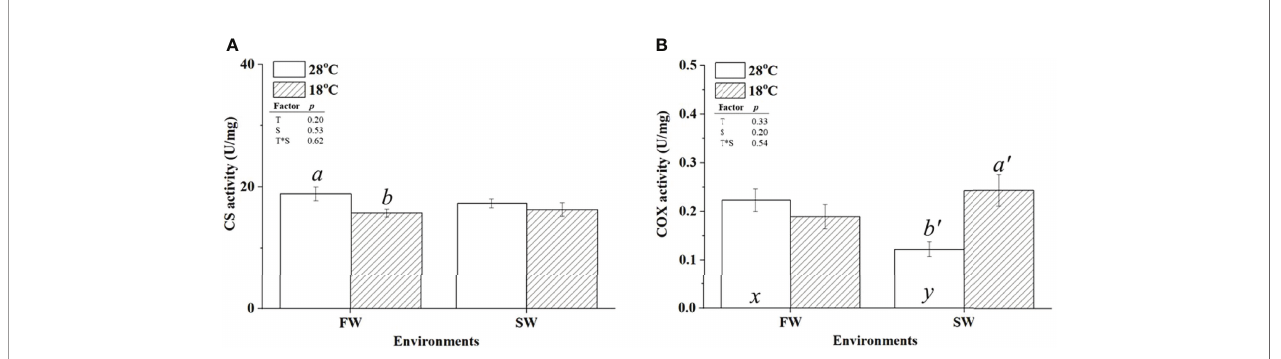
FIGURE 5 | Activity levels of citrate synthase (CS) (A) and cytochrome c oxidase IV (COX IV) (B) in the gills of milk fi sh acclimated to 28°C (white bar) and 18°C (striped bar). Different letters in the FW milk fi sh (a, b) and SW milk fi sh (a ’ , b ’ ) indicate signi fi cant differences between the normal and low-temperature groups. The x and y indicate signi fi cant differences between the FW and SW groups at 28°C or 18°C. Values represent the mean ± standard error of the mean (SEM), n = 9, P